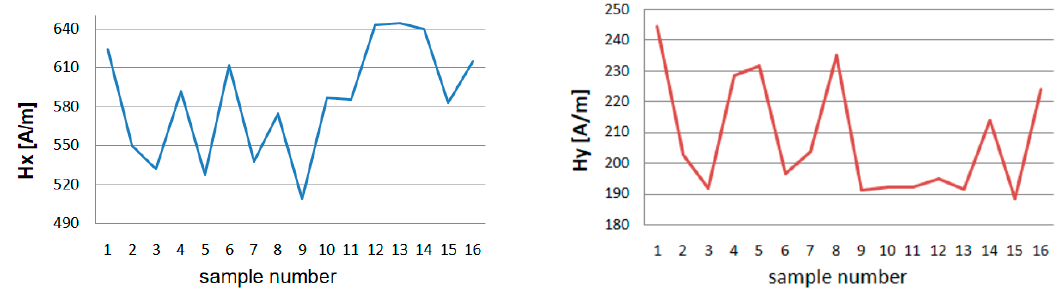
Figure 7. Maximum of tangential Hx and normal component Hy after repeatedly applying variants B, C, D, for 4 days long. A, B, C, D, for 4 days long .